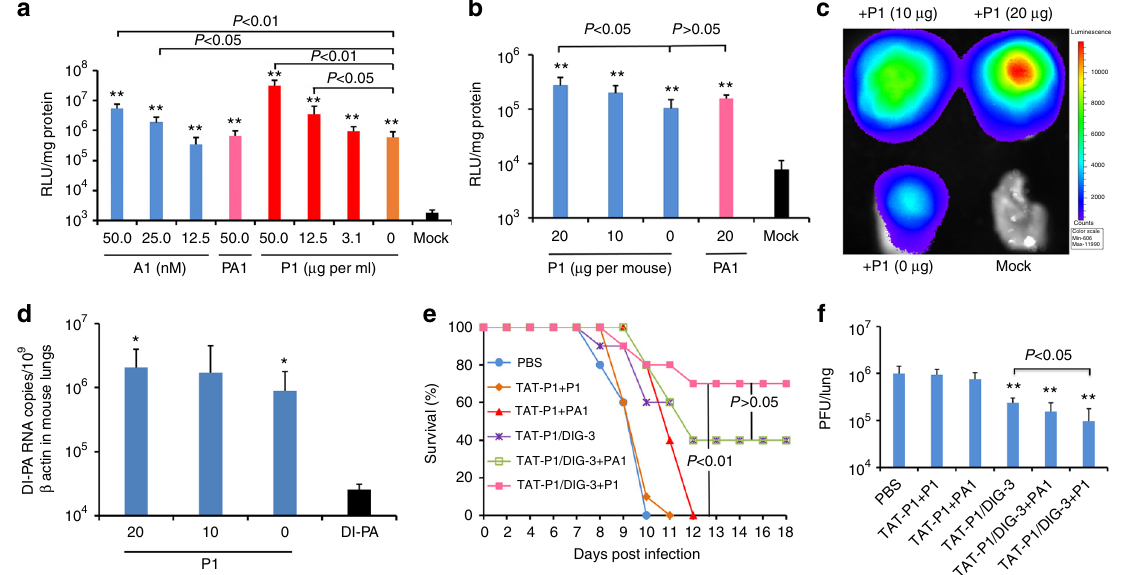
Fig. 7 The transfection ef fi ciency and antiviral activity of TAT-P1 with DIG-3 could be increased by P1 peptide. a Transfection ef fi ciency of TAT-P1/pLuc increased by additional ATPase inhibitor (ba fi lomycin A1) or P1 peptide. Before TAT-P1/pLuc (2.0 μ g/0.5 μ g) complex was added to 293T cells for transfection, the indicated concentrations of ba fi lomycin A1 (A1, nM), P1 peptide ( μ g per ml), or PA1 peptide ( μ g per ml) were added to cell culture media. Mock indicates cells treated with A1 or TAT-P1 without DNA. Data were presented as mean ± SD of three independent experiments. b Transfection ef fi ciency of TAT-P1/pCMV-Luc increased by P1 in mouse lungs. c Representative In Vivo Imaging System image showed increased luciferase expression by P1 in mouse lungs. TAT-P1/pCMV-Luc (20 μ g/5 μ g) with additional P1 (20 μ g, 10 μ g, or 0 μ g) or PA1 (20 μ g) were inoculated to mouse lungs at 48 and 24 h before measuring bioluminescence signal or taking bioluminescence image. Mock indicates mouse lungs inoculated with TAT-P1 + P1 without DNA. d The RNA expression of DI-PA increased by P1 in mouse lungs. TAT-P1/DI-PA (20 μ g/5 μ g) with additional P1 (20 μ g, 10 μ g, or 0 μ g) were inoculated to mouse lungs at 48 and 24 h before detecting RNA expression. Data were presented as mean ± SD of ≥ 3 mice. * Indicates P < 0.05 and ** Indicates P < 0.01 when normalized to Mock ( a , b ) or naked plasmid of DI-PA ( d ). e , f The prophylactic ef fi cacy of TAT-P1/DIG-3 + P1 against A(H1N1)pdm09 virus. PBS ( n = 10), TAT-P1 + P1( n = 10) or TAT-P1 + PA1 (20 μ g + 20 μ g, n = 5), TAT-P1/DIG-3 (20 μ g/5 μ g, n = 10), TAT-P1/DIG-3 + PA1 (20 μ g/5 μ g + 20 μ g, n = 5), or TAT-P1/DIG-3 + P1 (20 μ g/5 μ g + 20 μ g, n = 10) were intratracheally inoculated to corresponding mice at 48 and 24 h before viral inoculation.